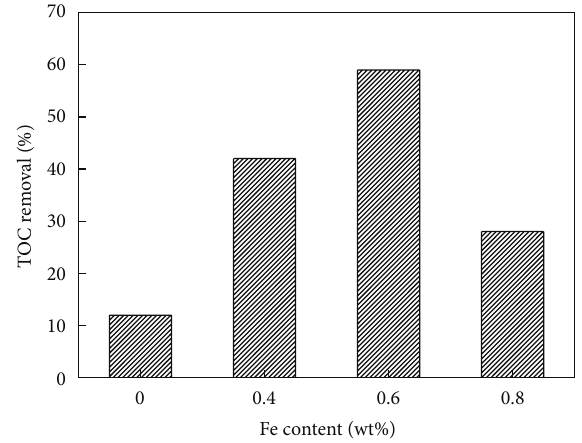
Figure 5: TOC removal on the photocatalytic degradation of humic acid by Fe-TiO 2 /SAC with different Fe content under light irradiation with wavelength range of 315 ∼ 400 nm for 6 h.